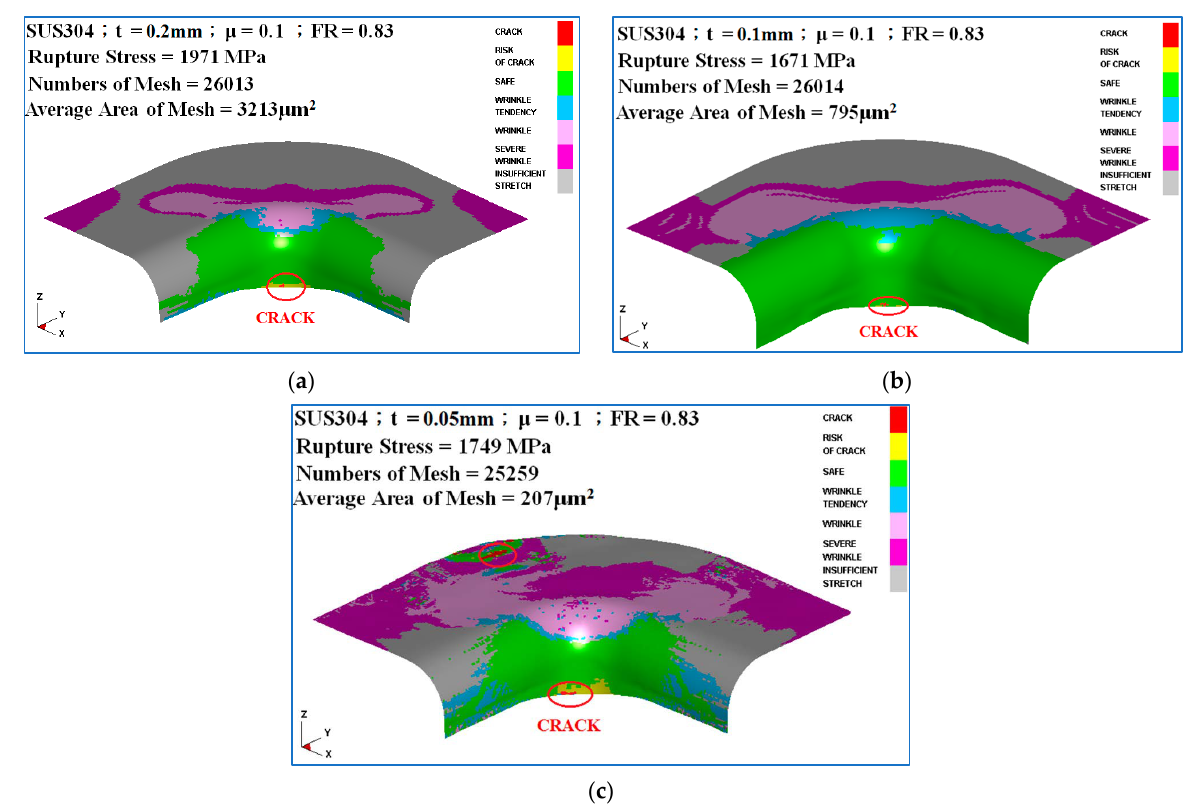
Metals 2021 , 11 , x FOR PEER REVIEW Figure 13. Sheet material forming limit diagram: ( a ) Model 1; ( b ) Model 2; ( c ) Model 3. 4.3.1. The Relationship between the Load and Stroke of the Punch with Different FR Figure 14 is a graph of the relationship between the punch load and the stroke for different forming ratios. As shown in the figure, the punch load decreases as the value of FR increases. The reason is that the larger forming ratio results in a larger hole. The contact area between the punch and the sheet is smaller, and so the load of the punch is smaller. A longer stroke must be taken with smaller values of FR .